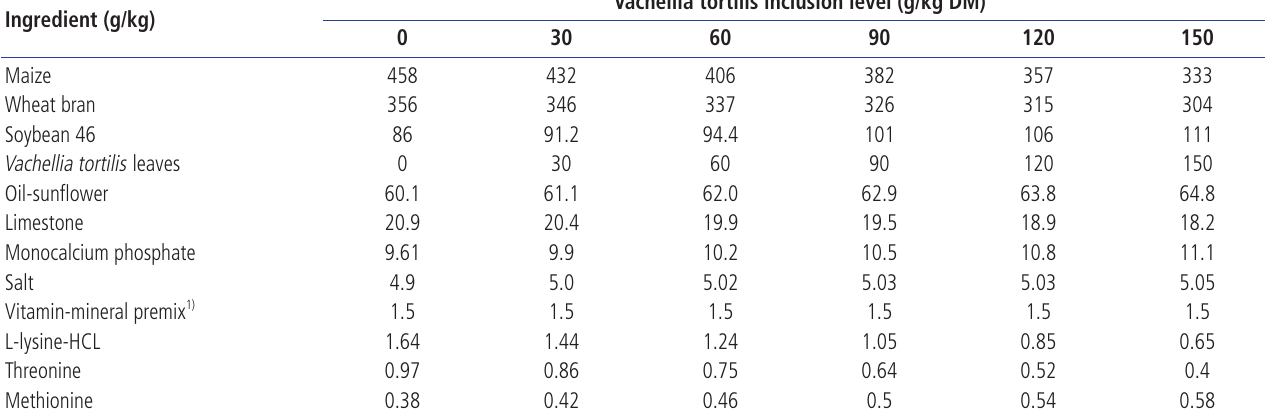
Table 1. Ingredient composition of experimental diets (g/kg DM) Ingredient (g/kg)